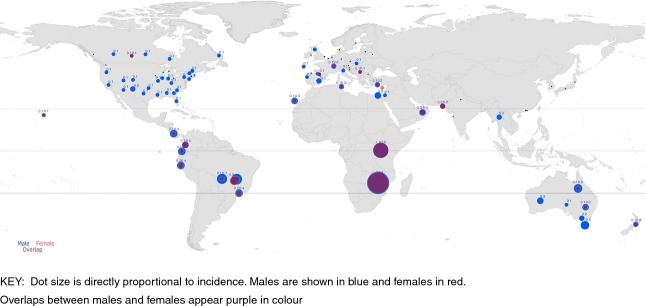
Worldwide mapping of the age-standardized incidence rates (ASR) of squamous cell carcinoma of the eye (ICD-O-3 C.69) for the period 1998–2002 (Curado et al. 2007). Key: Dot size is directly proportional to incidence. Males are shown in blue and females in red. Overlaps between males and females appear purple in colour.